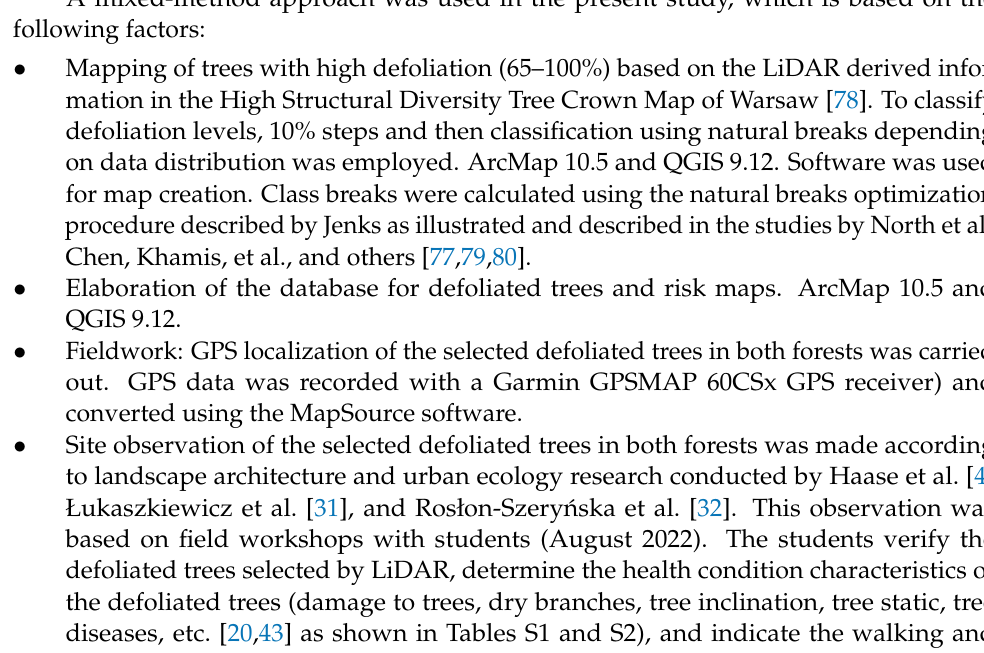
Figure 2. The research framework (author’s own elaboration).